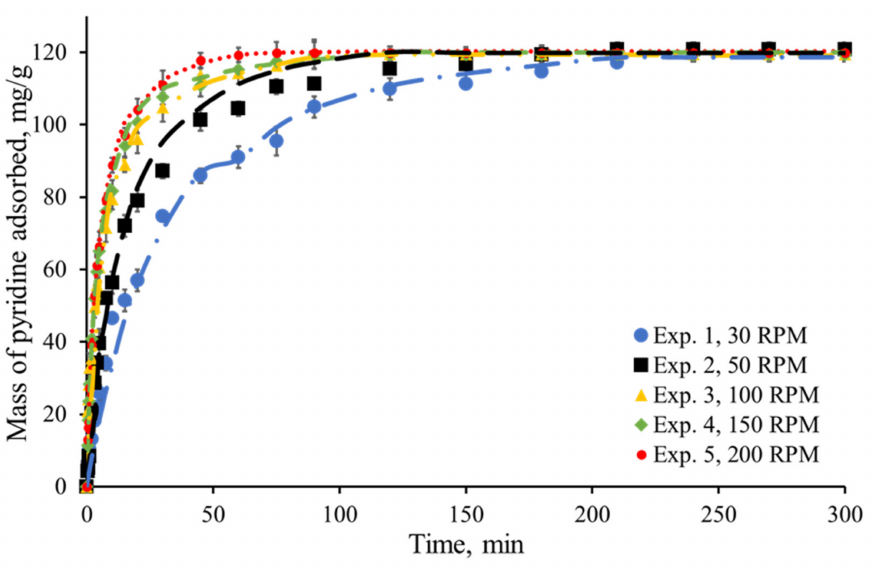
Figure 7. Variation in ACC adsorption capacity as function of the agitation rate. Predictions from the advection–diffusion model are represented by dashed lines, while the discrete values correspond to experimental data.